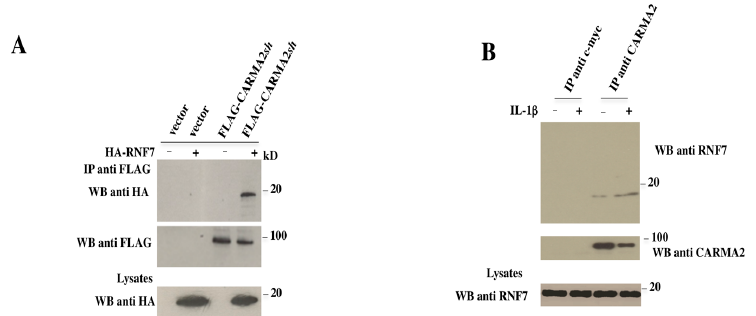
Figure 1. RNF7 binds to CARMA2 sh . ( A ) HEK293T cells were cotransfected with a plasmid encoding